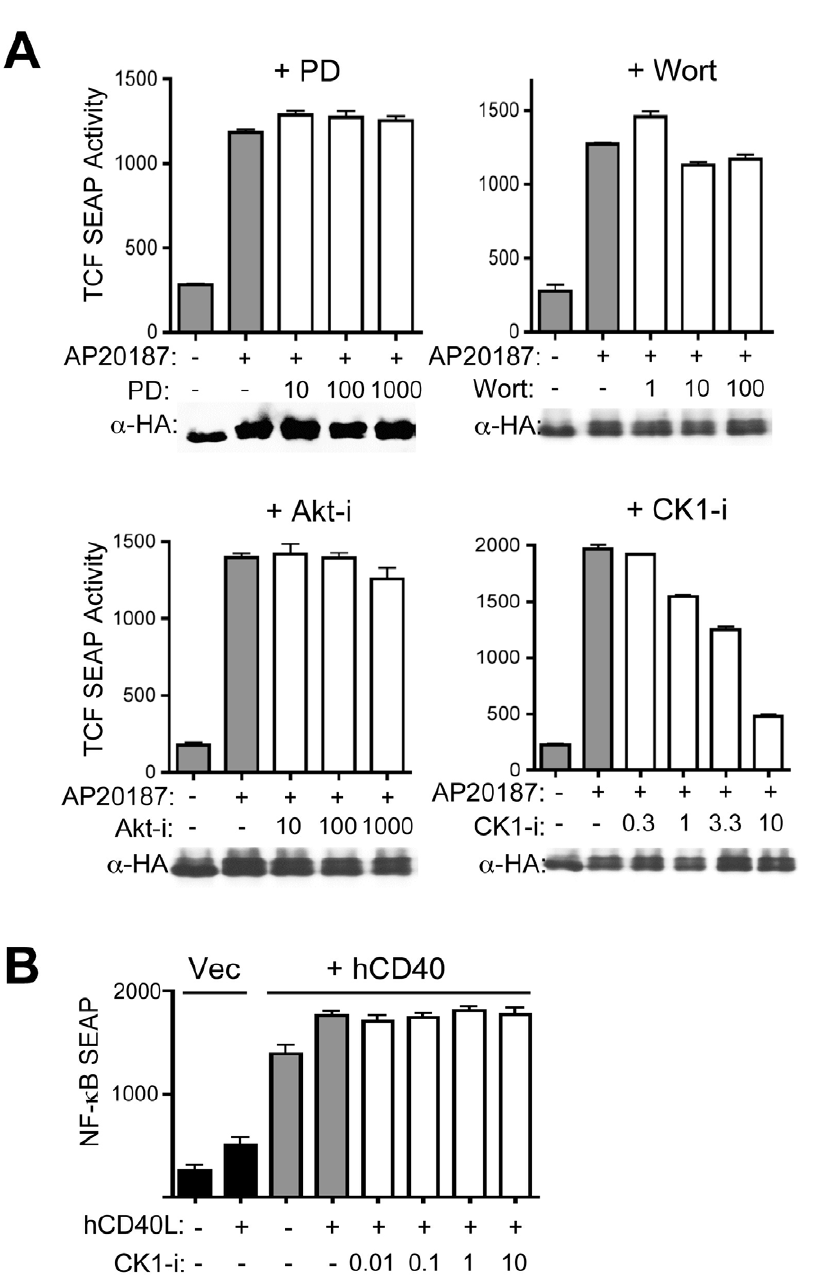
Figure 4. CK1 is required for iLRP5-mediated b -catenin activation. ( A ) 293 cells were co-transfected with 1 m g TCF-reporter and iLRP5 construct and incubated for 24 hours with indicated concentrations (nM) of MAPK (PD98059 (PD)), PI3K (wortmannin (Wort)), Akt (Akt-i), or casein kinase 1 (CK1-i) inhibitor. ( B ) 293 cells were co-transfected with 1 m g NF- k B-reporter and hCD40 construct and incubated for 24 hours with indicated nM concentrations of CK1-i plus hCD40L (1 m g/mL). SEAP activity was measured after an additional 24-hour incubation with or without 100 nM CID (AP20187). Data is representative of at least two independent experiments. The amount of protein expression was normalized by anti-HA blot ( a -HA).